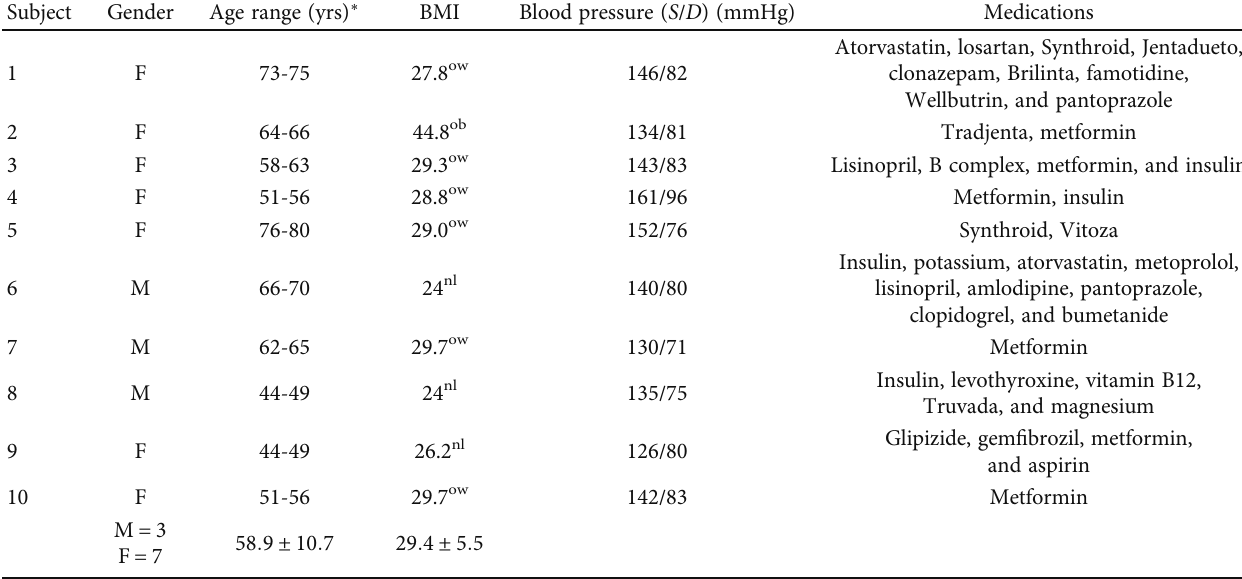
This table represents the study participants characteristics: study subject number (No), gender, age range (years), calculated body mass index (BMI) (nl: normal weight; ow: overweight; ob: obese), baseline blood pressure (systolic/diastolic), and current medications. Mean and standard deviation (SD) for each column. ∗ Age range is used to protect any participant identi fi able